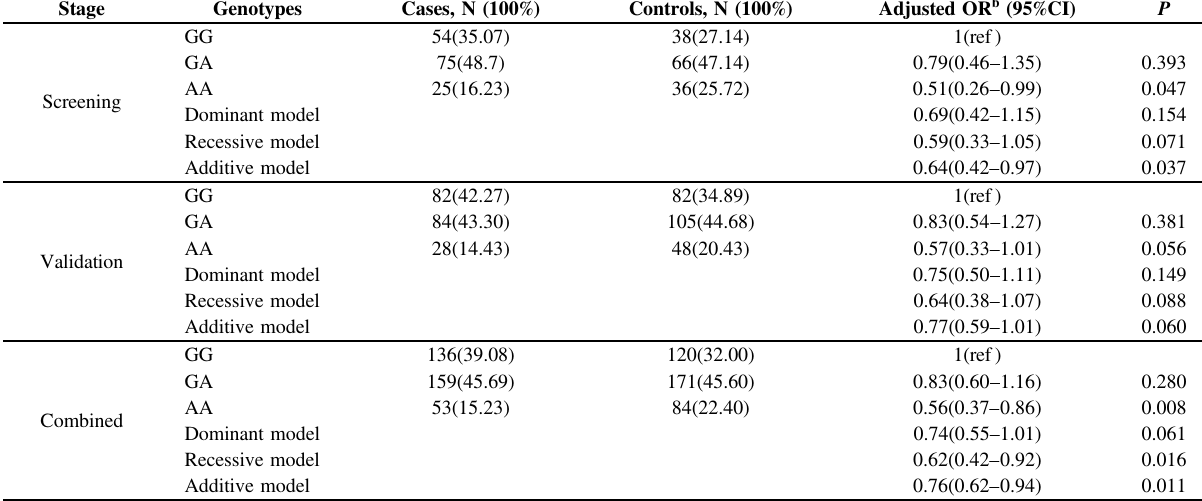
Table 3 Speci fi c information of rs1814521 in di ff erent